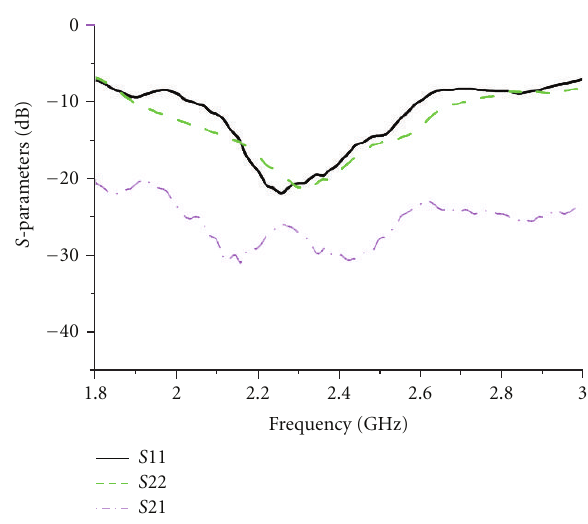
Figure 9: Measured S